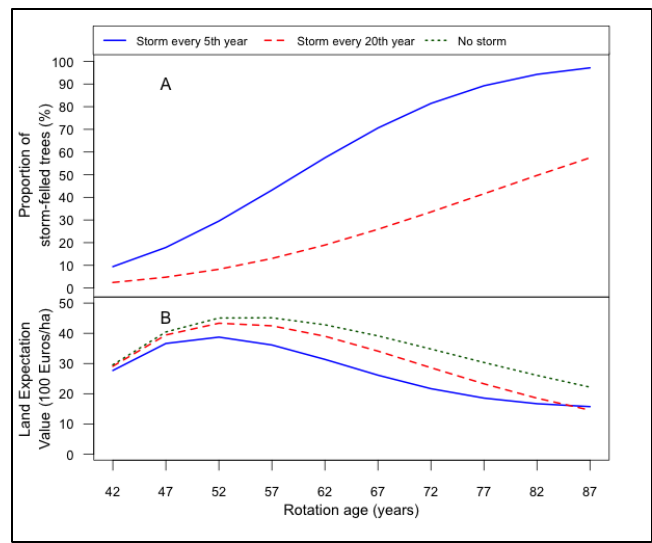
Figure 3. Storm-felled stem volumes, as proportions of total stem volumes ( A ), and land expectation values ( B ), if a major storm with the magnitude of Gudrun occurred never, once every fifth year and once every 20th year in Norway spruce stand in southern Sweden.